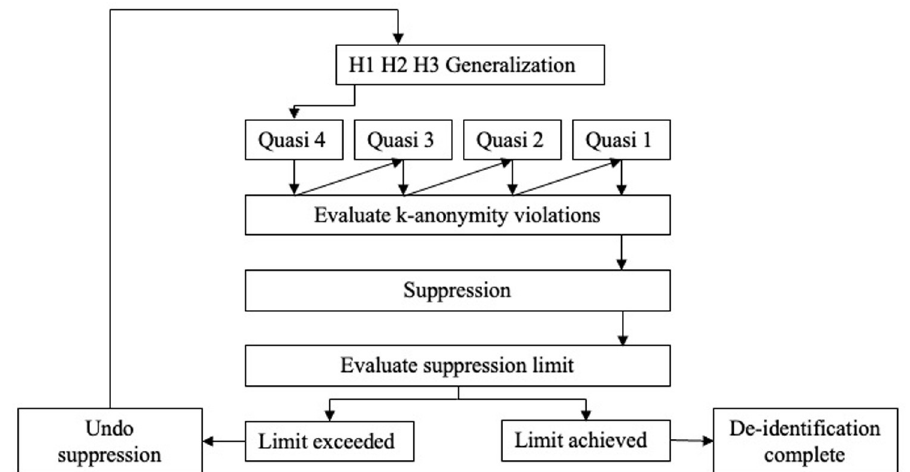
Fig 3. De-identification schematic. H1-H3 refer to consecutive generalization hierarchies. Numbers assigned to quasi-identifiers correspond to relative importance ranking.